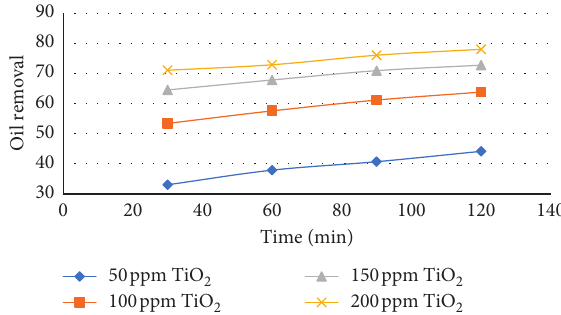
Figure 2: TiO 2 effect on removal of PW at pH